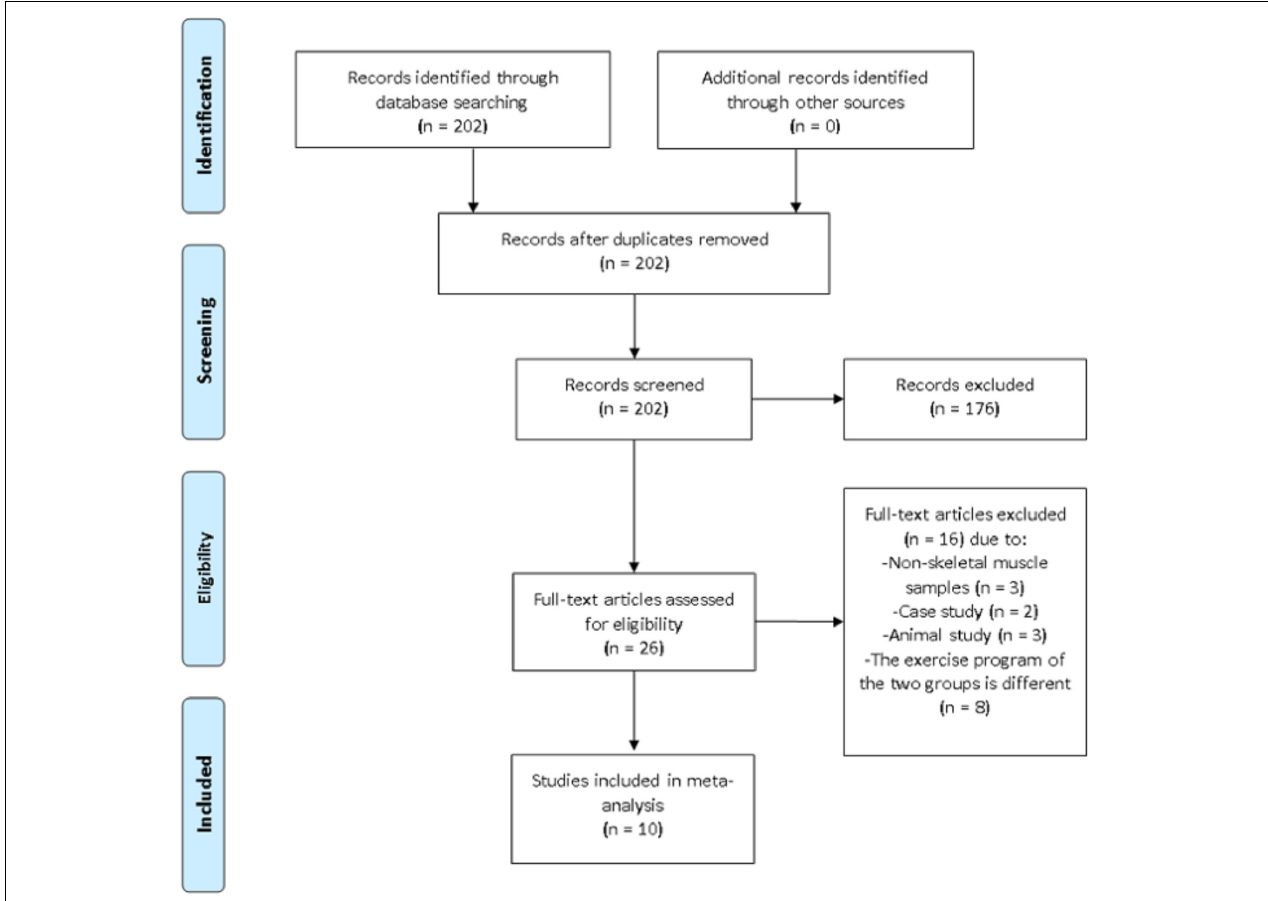
FIGURE 1 | Preferred reporting items for systematic reviews and meta-analysis (PRISMA) flow diagram of search